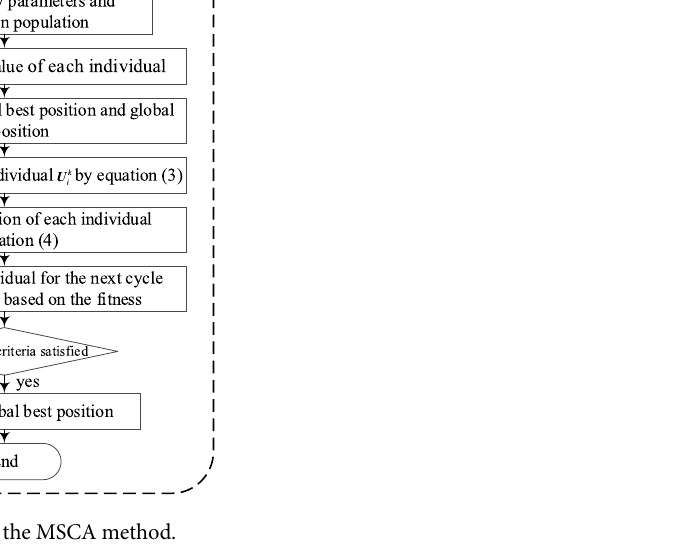
Figure 3. Flowchart of the MSCA